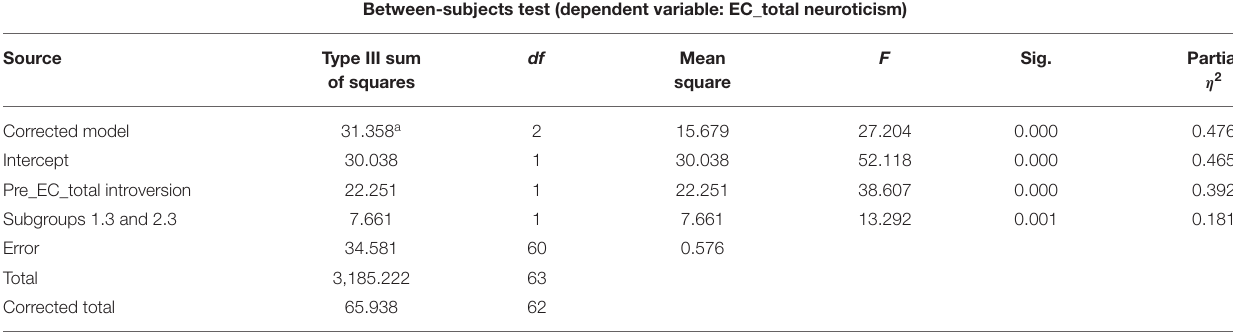
TABLE 4 | ANCOVA results for emotional competences development (ECD): neuroticism. Between-subjects test (dependent variable: EC_total neuroticism)